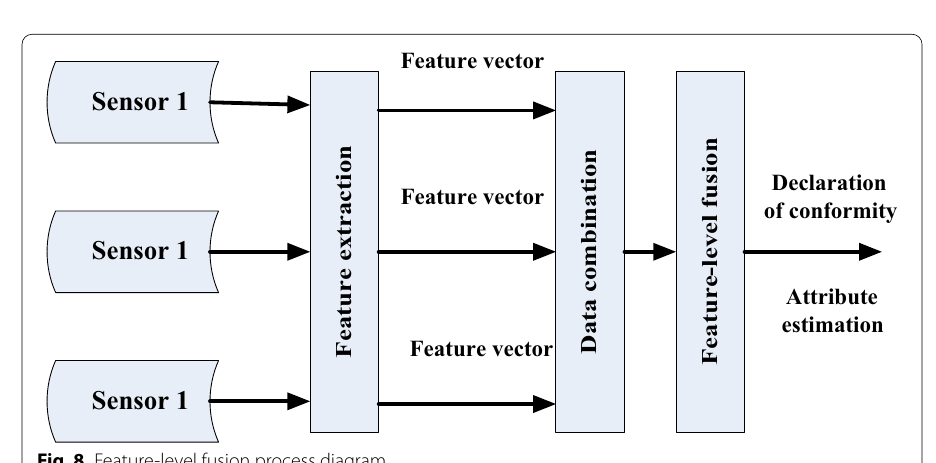
Fig. 8 Feature-level fusion process